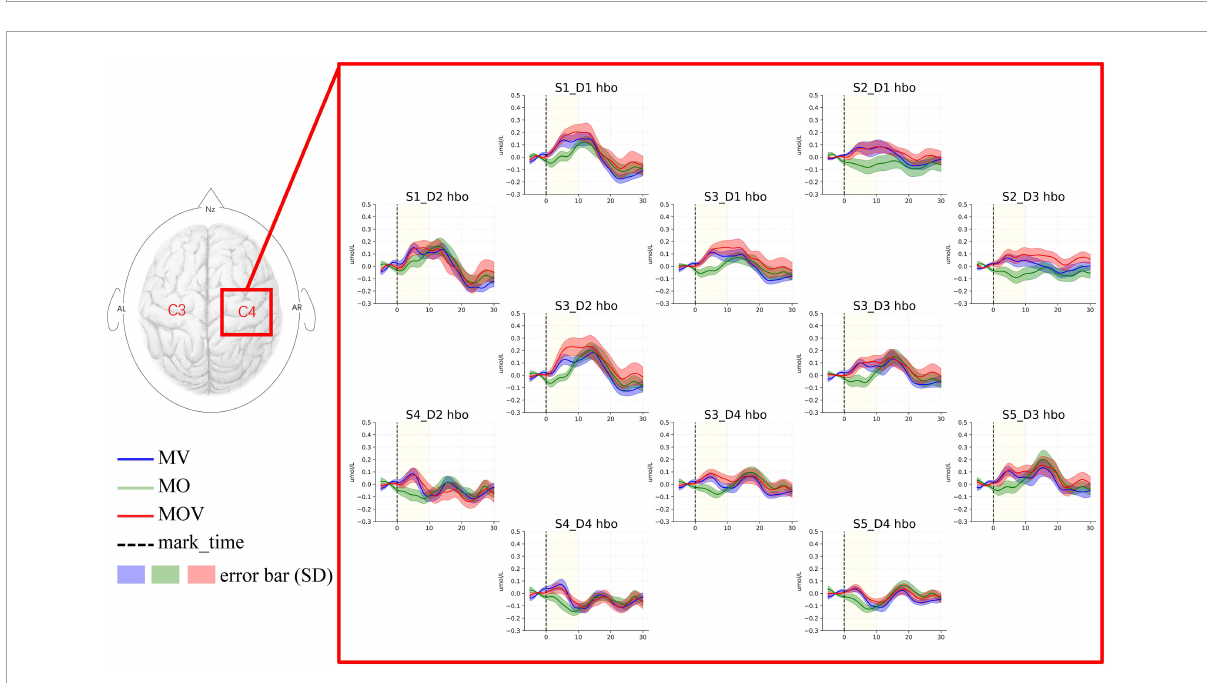
FIGURE7 HbO topography of the right-brain sensorimotor. This figure shows the changes in HbO in the 12 fNIRS channels around C4 in the right-brain region under the three rehabilitation tasks. The task is performed from 0 s onward in each subplot, with the start moment indicated by the black dashed line. The task starts with a 5 s rest period before the start of the task. The task duration is the length of the 10 s time corresponding to the light-yellow shading. The blue, green, and red lines indicate the MV, MO, and MOV rehabilitation tasks. The different shaded areas are the error bar (HbO data for 14 subjects in that channel for that task. Standard deviation) corresponding to each line.